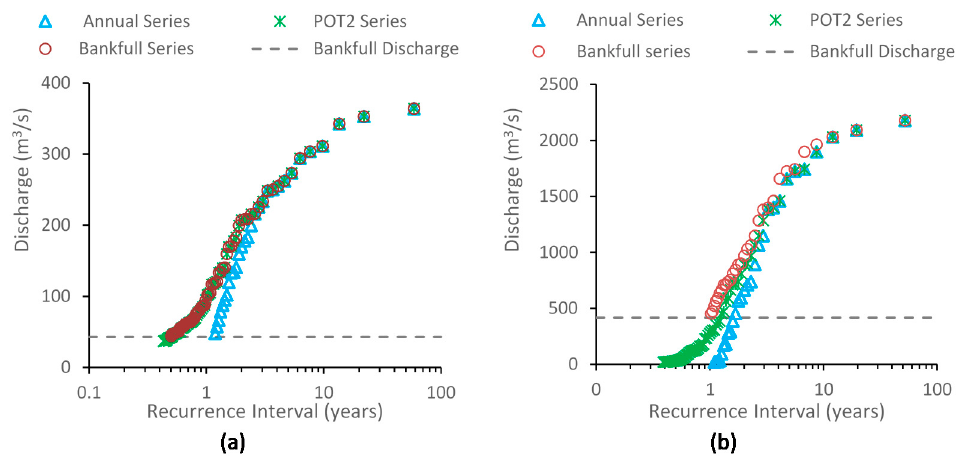
Figure 6. Comparison of flood magnitudes between the AM, POT and BF series for different recurrence intervals for: ( a ) a wet tropical catchment (Site ID 114); and ( b ) a dry tropical catchment (Site ID 119).